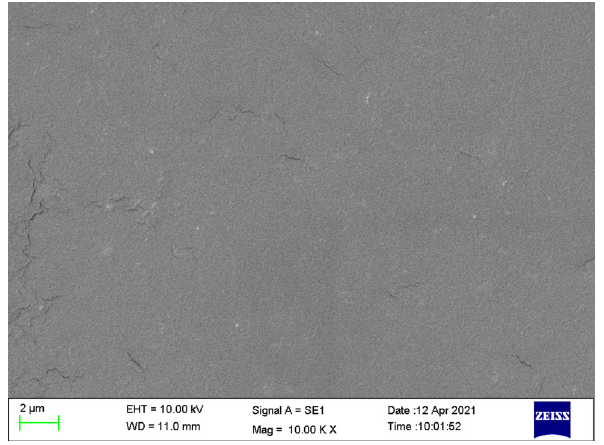
Figure 11: Scanning electron micrographs of P 2